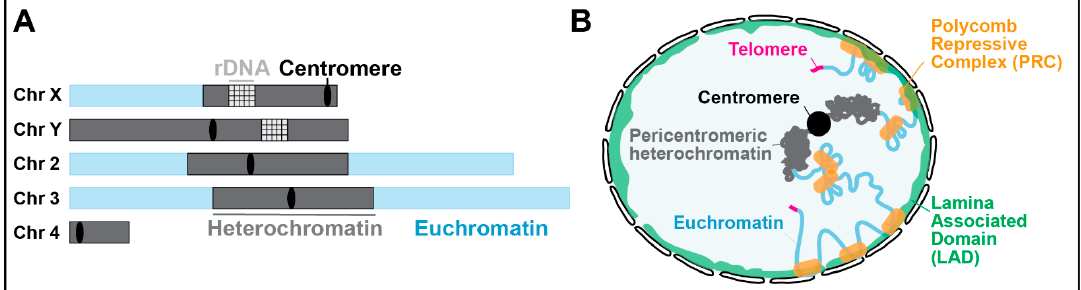
Figure 1. Chromosomal and nuclear position of pericentromeric heterochromatin. ( A ) Schematic view of Drosophila chromosomes showing the position and extent of pericentromeric heterochromatin (adapted from [5]). The Y chromosome is mostly heterochromatin. ( B ) Position of pericentromeric heterochromatin relative to the nuclear periphery in a Drosophila nucleus, which is distinct from LADs, telomeric repeats, and Polycomb-repressed domains (adapted from [7,18]).